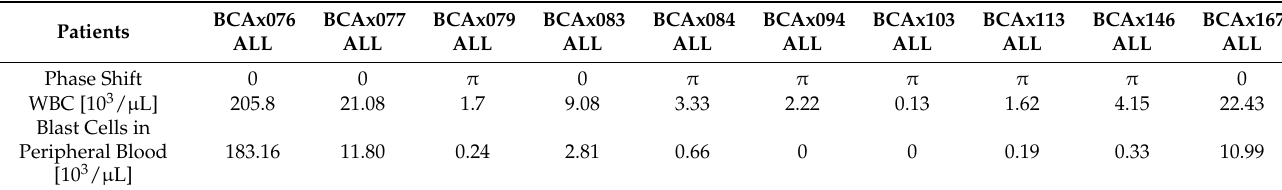
Table 3. Correlations between phase shift and WBC and blast cell counts in peripheral blood for BCP-ALL patients.